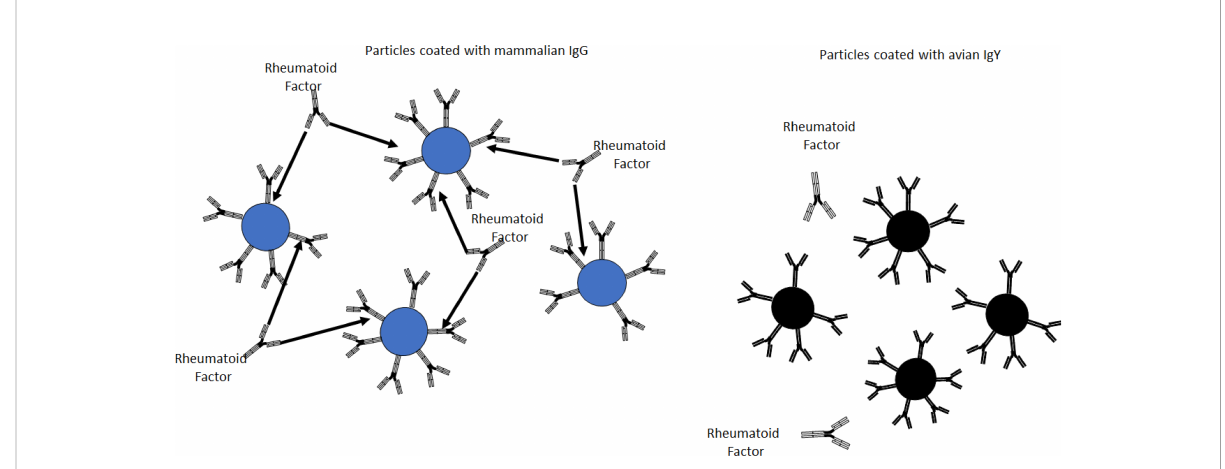
FIGURE 4 Rheumatoid factor-positive sera agglutinated particles coated with mammalian IgG (left) but not particles coated with chicken IgY